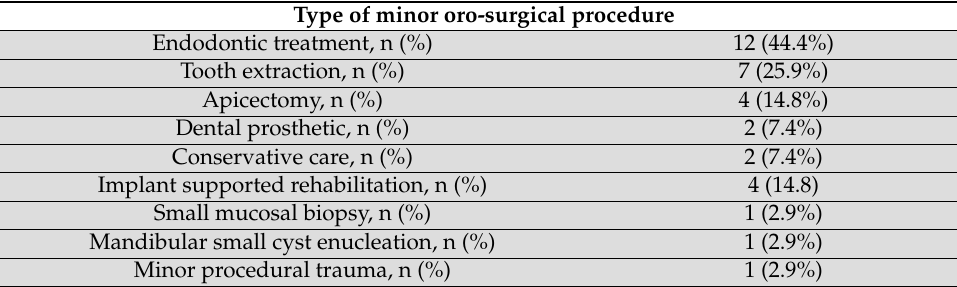
Table 5. Minor oro-surgical procedures in the PIFP population (34